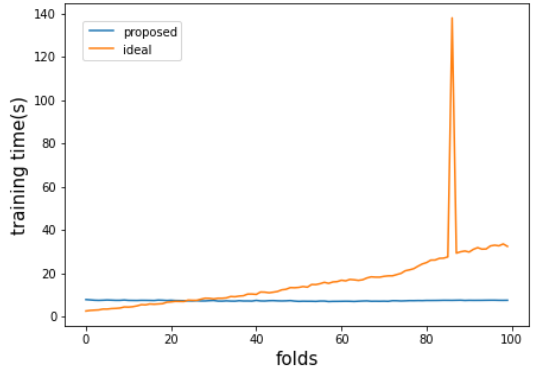
Figure 6. Training time per unit data input of the proposed method and the ideal method when the size of the pure dataset is 20,000 and the proportion of attack data is